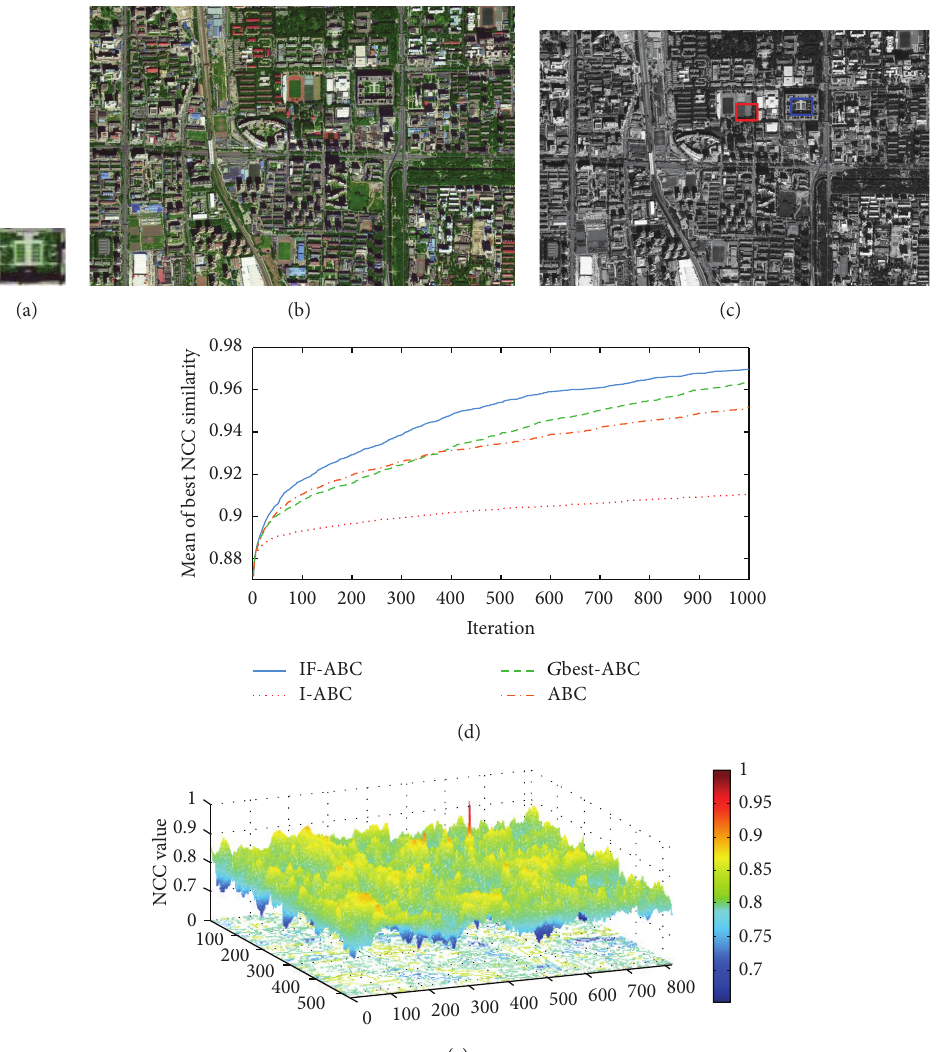
Figure 5: Ideal template matching case 3: satellite imagery of Beihang University campus. (a) Predefined template image (51 × 41); (b) source image (870 × 570); (c) ground matching truth (blue box) and most common false matching result (red box); (d) comparative evolution curves of four ABC algorithms; (e) surface illustration of searching